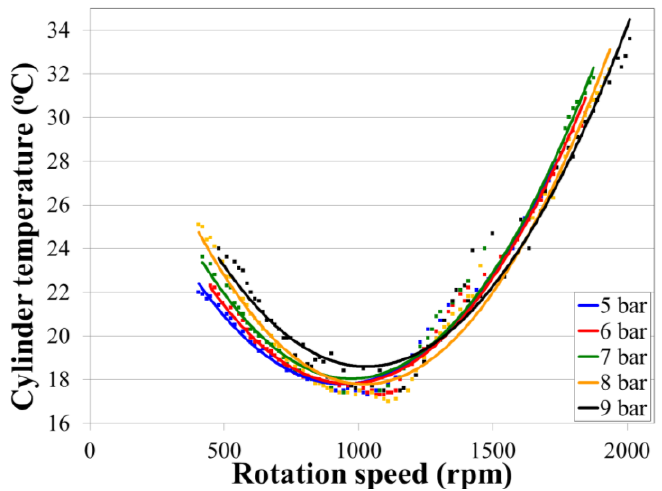
Figure 11. Cylinder temperature variation acquired during experiments at 6 bar and different rotation